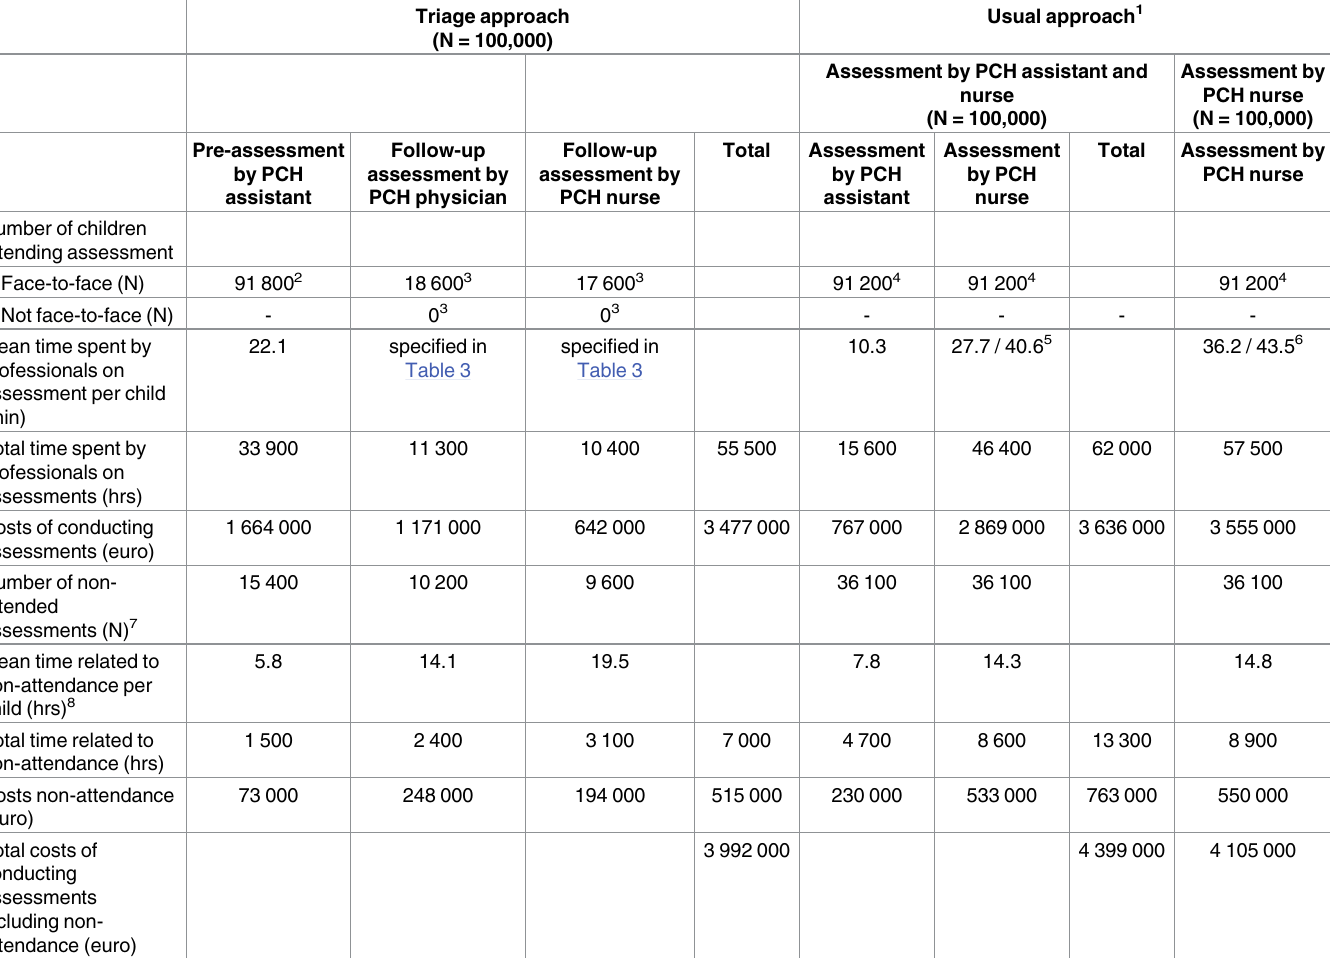
Table 2. Costs (2013 € ) associated with the time spent by PCH professionals on preventive assessments of child health in the triage approach and the usual approach for children aged 10/11 yearson the basis of a cohort of 100,000children per